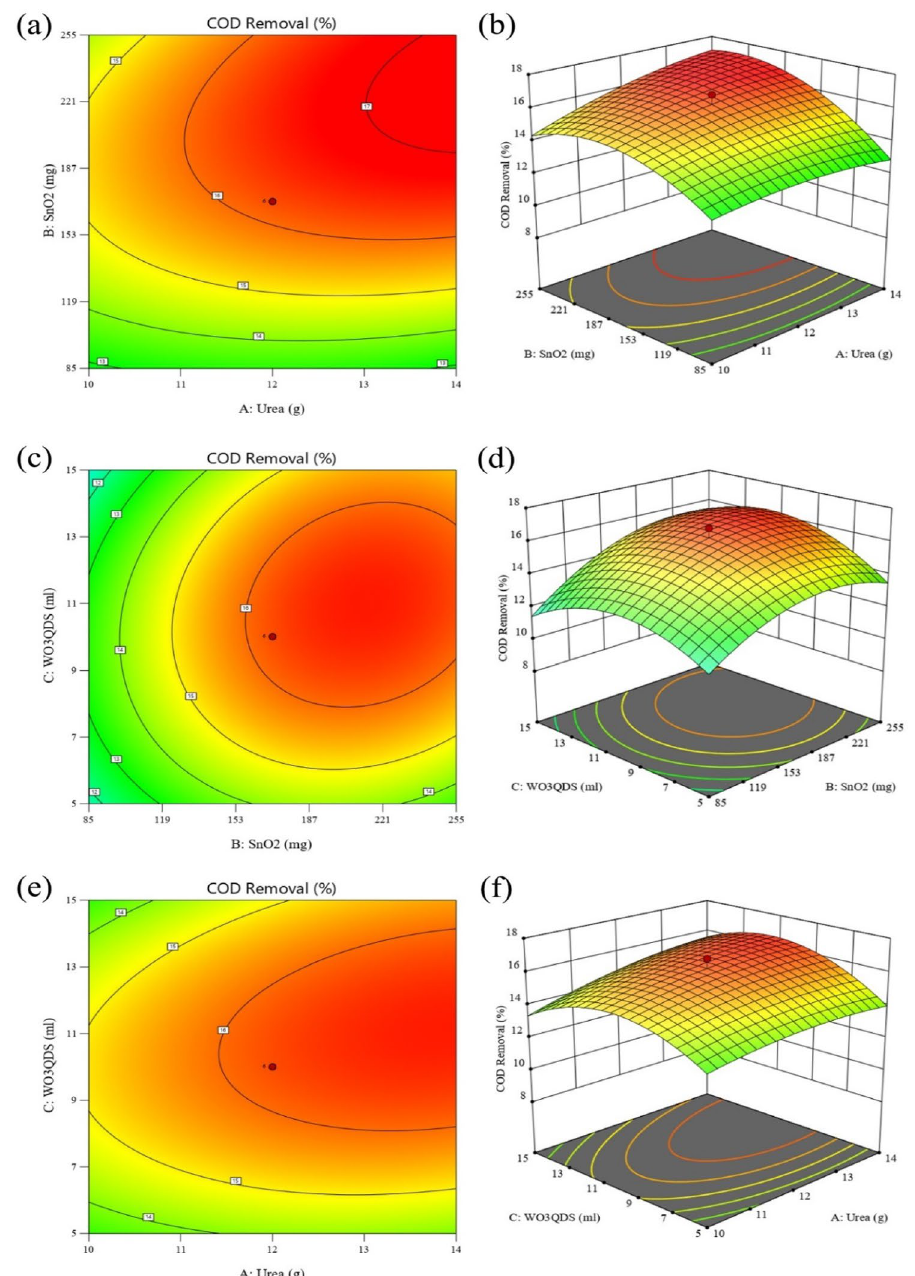
Figure 3. 3D response surface graphs and contour plots for leachate photodegradation: ( a , b ) SnO 2 vs. urea, ( c , d ) SnO 2 vs. WO 3 QDs solution, and ( e , f ) urea vs. WO 3 QDs